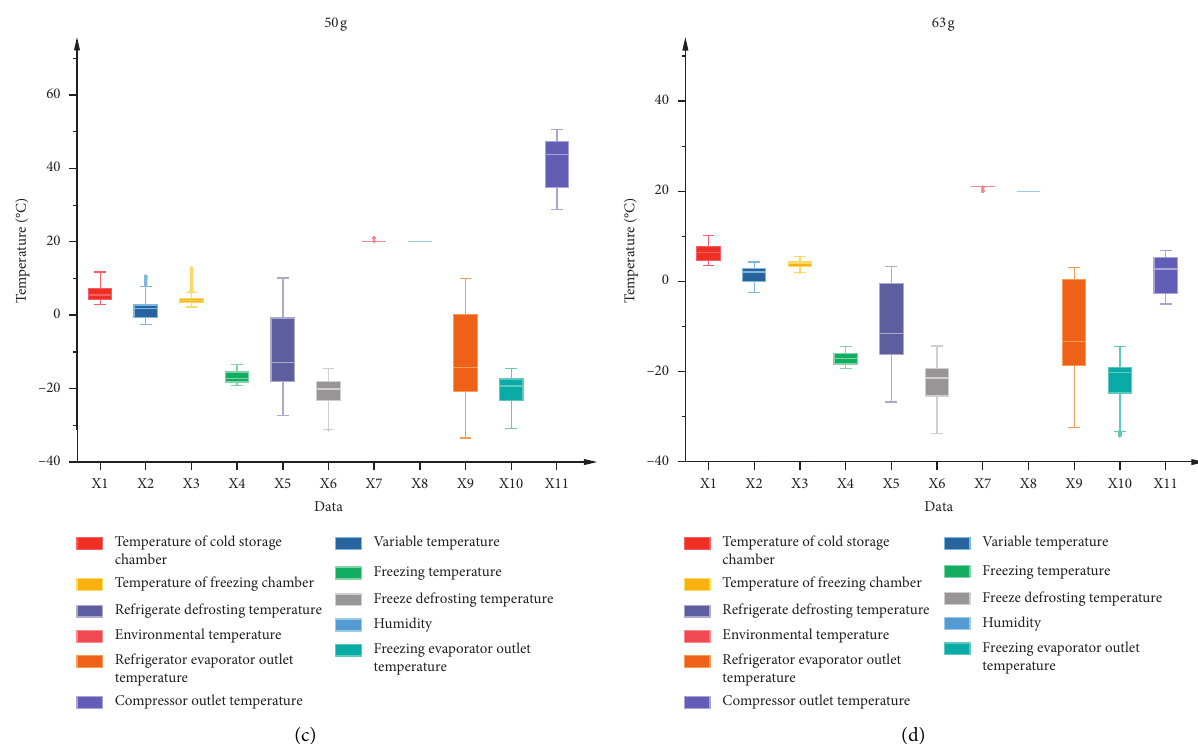
Figure 5: Box plots by refrigerant amount: (a) 37.5 g, (b) 40g, (c) 50g, and (d) 63g.